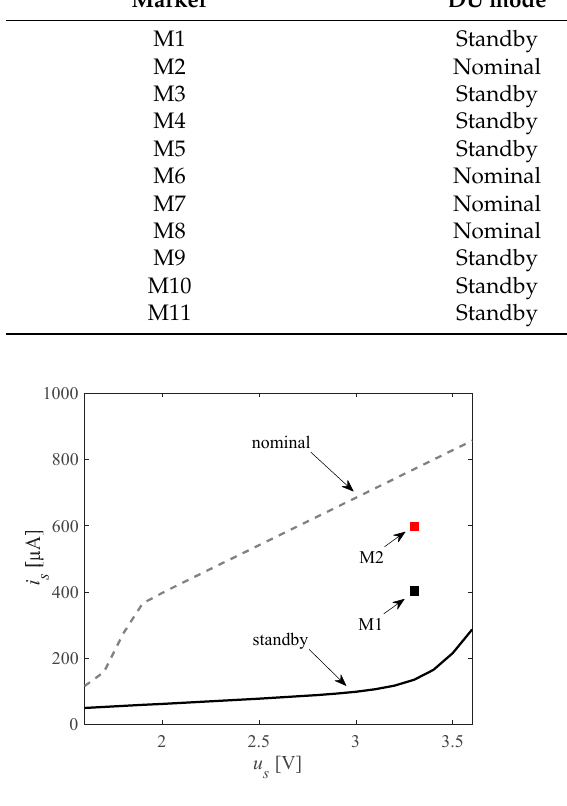
Figure 3. Current i s vs. voltage u s .